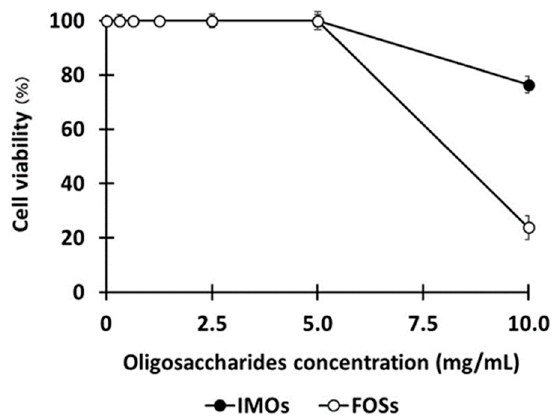
Figure 6. E ff ect of oligosaccharides on the cell viability of mammalian cells. Data are the means of three independent experiments and error bars represent the standard deviation. IMOs, isomaltooligosaccharides; FOSs, fructooligosaccharides.